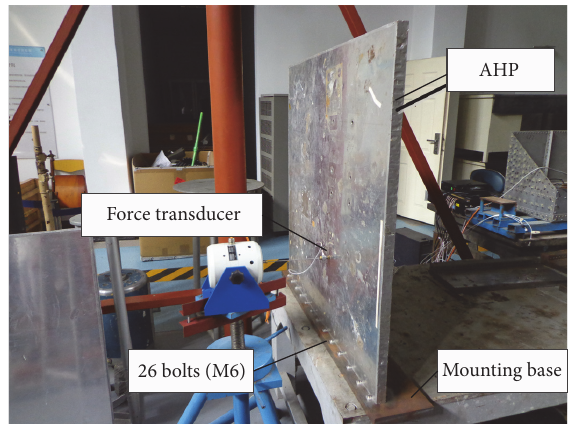
Figure 7: Experimental system for vibration test of the AHP with multiple bolts.